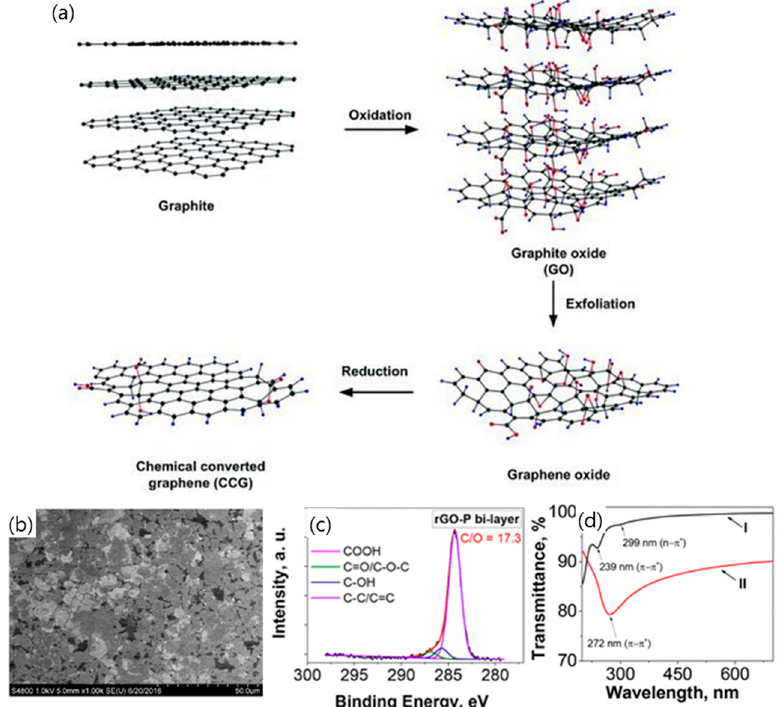
Figure 4. ( a ) Preparation of graphene by chemical reduction of graphene oxide synthesized by Hummers’ method. Reproduced with the permission of Reference [98]. Copyright 2012, Royal Society of Chemistry. ( b ) SEM images of reduced graphene oxide-P (rGO-P) bilayer film deposited on undoped Si wafer. ( c ) High-resolution C 1s spectra of rGO-P bilayer film. ( d ) Ultraviolet–visible (UV − vis) transmittance spectra of GP bilayer film (I) and rGO-P bilayer film (II). Reproduced with the permission of Reference [43]. Copyright 2018, American Chemical